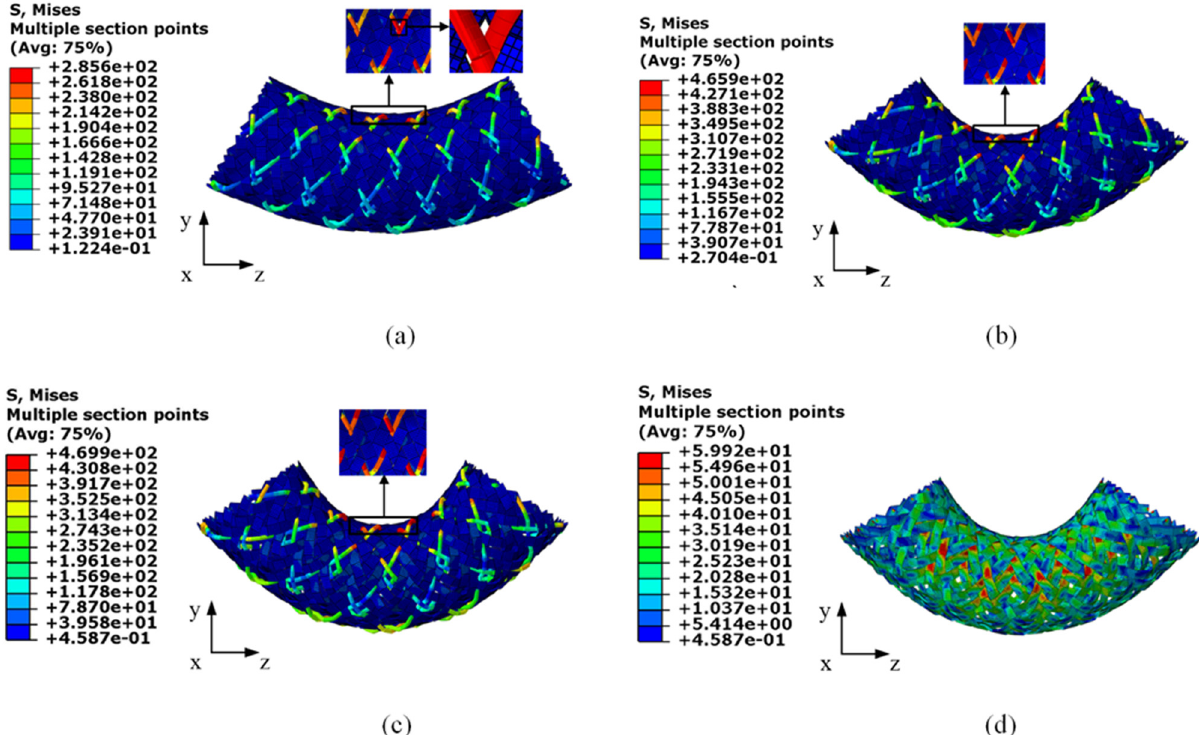
Figure 5: Stent deformation of case 1 at the bending angle of 30° ( a ) , 48° ( b ) , 60° ( c ) ( the zoom - in view on the XZ planes ) , and ( d ) PET strips at the bending angle of 60°.